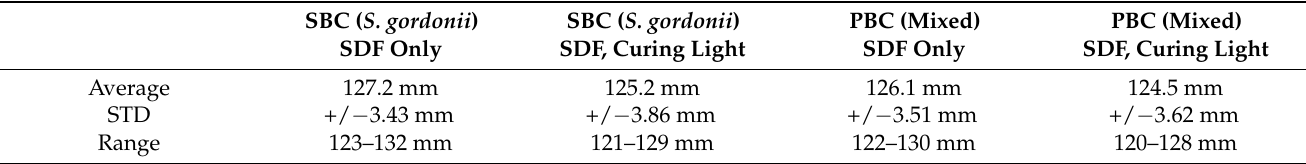
Table 1. ZIT-AA measurements for the single Gram-positive (SBC) and polybacterial cultures (PBC).